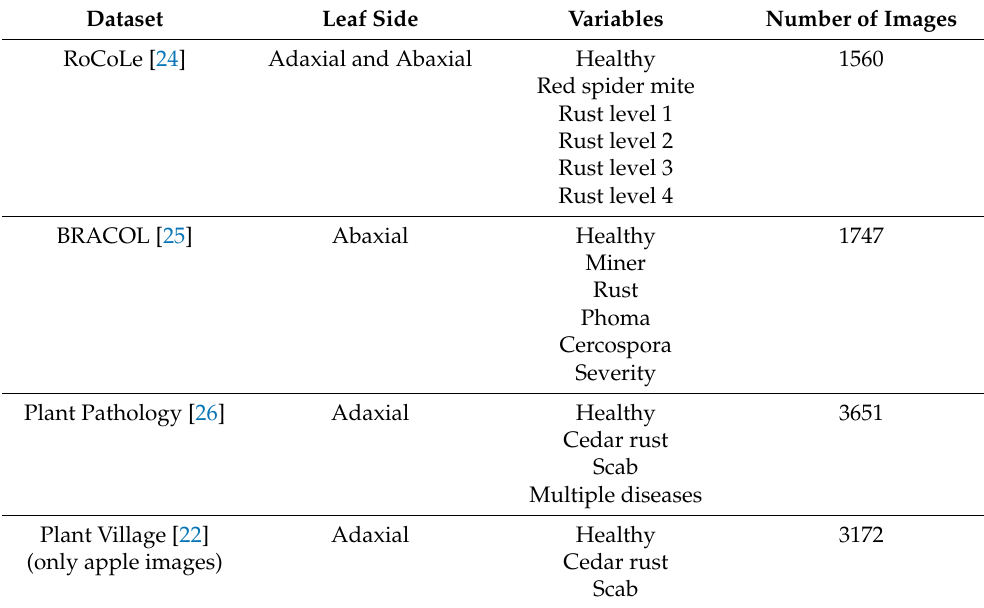
Table 1. The Table shows an overview of the datasets used, reporting the variables monitored and the total size, respectively. For a detailed description of the entire dataset, the reader is referred to the relevant manuscript.